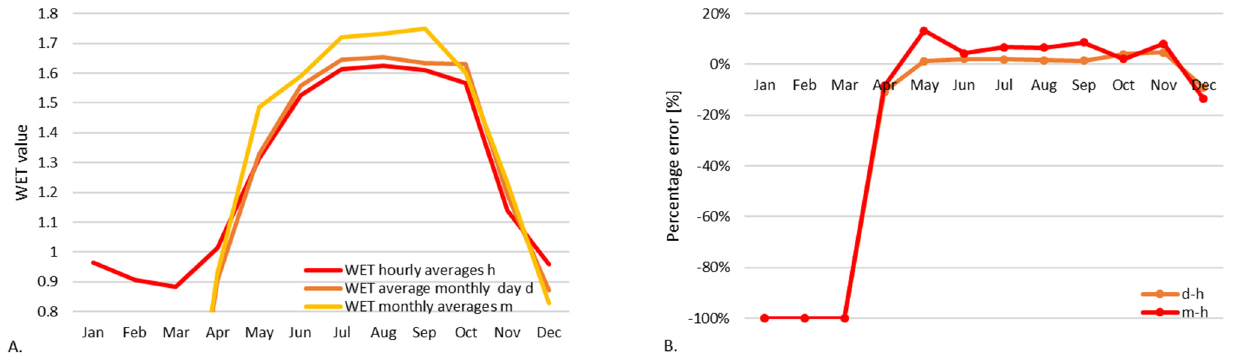
Figure 17. Paris WET values ( A ) and percentage error ( B ).